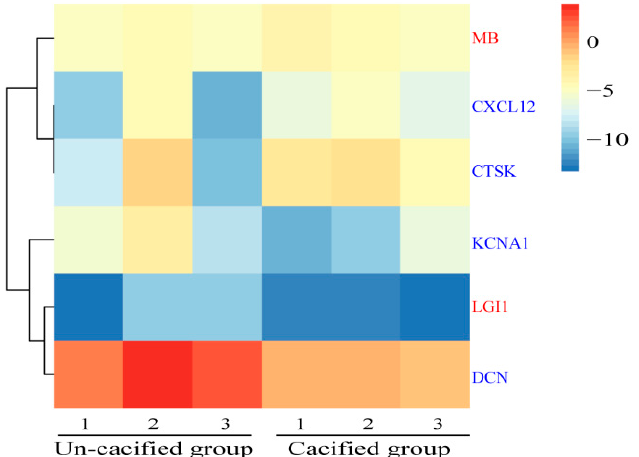
Figure 8. The expression patterns of some differential expression genes (DEGs) in muscles and bones detected by RT-PCR. The gene expression values are transformed to a log2 scale. Different groups of genes are distinguished by different colors, in which red represents the labels of DEGs from muscles and blue represents the labels of secretory proteins from bones.